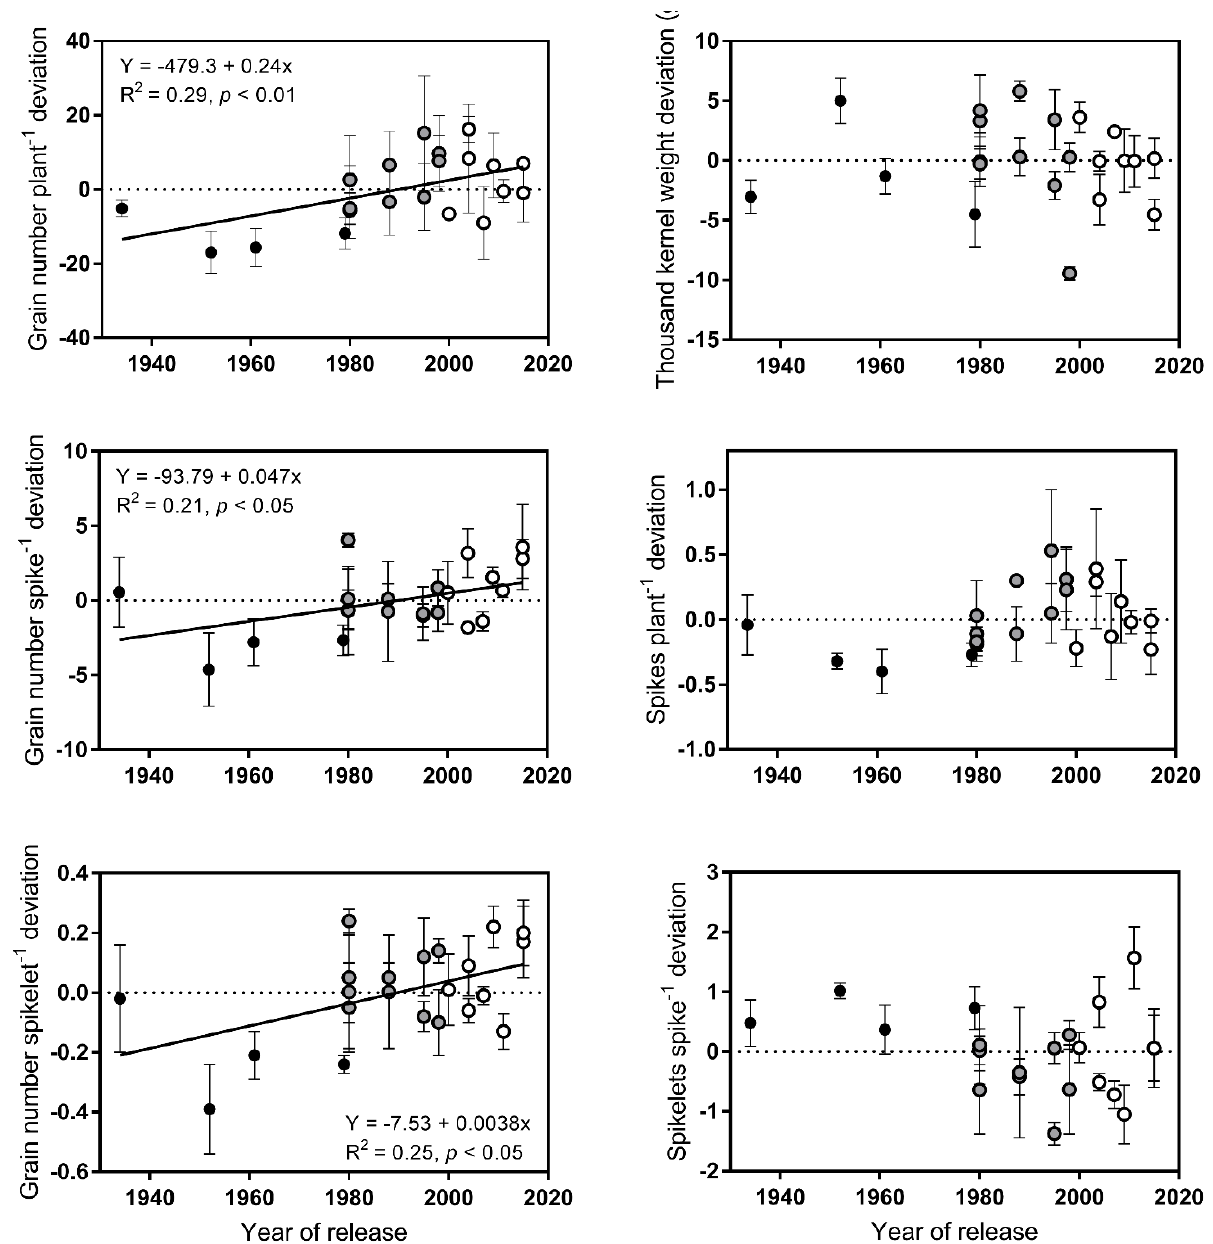
Figure 4. Regression analyses between grain number per plant, thousand kernel weight, grain number per spike, spikes per plant, grain number per spikelet and spikelets per spike deviations and the cultivar’s release year. Each point represents the average of trait deviation for each cultivar with respect to the mean value in each experiment (Cabildo and Pieres in 2014 and Barrow in 2017). Black, grey and white points correspond to the cultivars released in the periods 1934–1979, 1980–1999 and 2000–2015, respectively. Horizontal dotted lines represent the mean value of the trait for each experiment, and the vertical lines for each point represent the standard error of the mean.